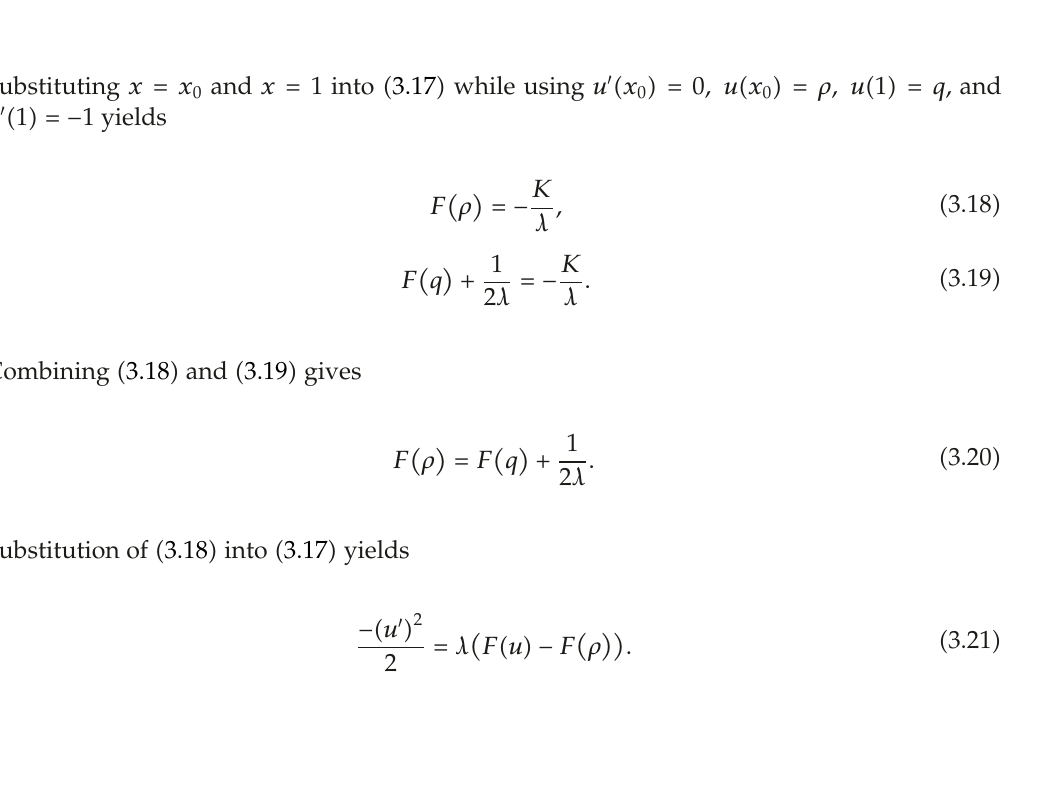
Figure 7: Typical solution of (cid:4) 3.14 (cid:5) – (cid:4) 3.16 (cid:5)